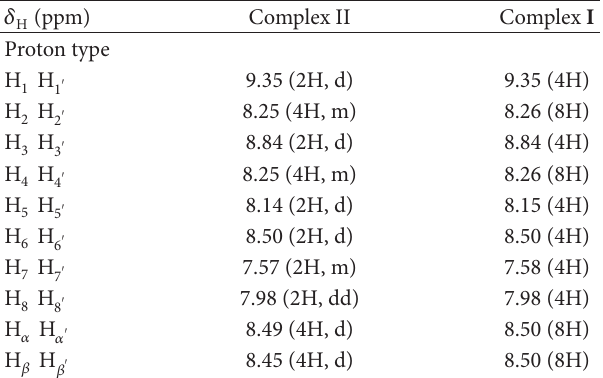
Figure 2. e absorption maximum of 380 nm